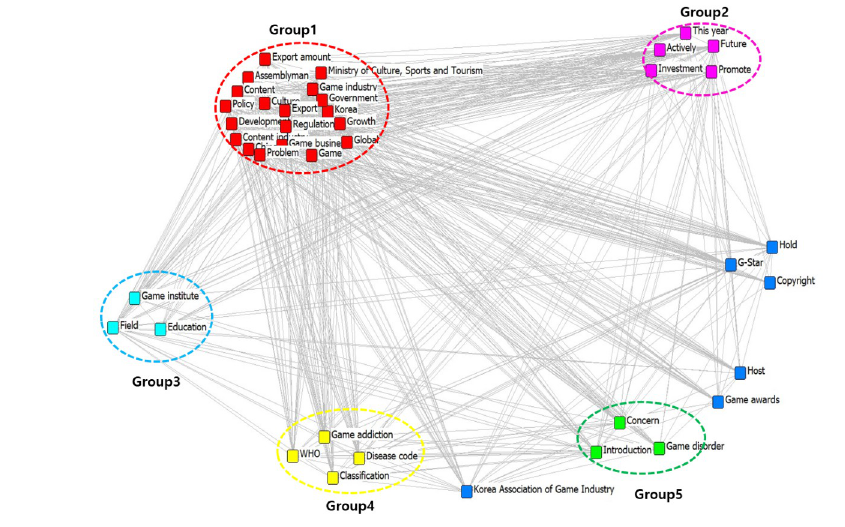
Fig 7. Visualization of CONCOR analysis in 2019.